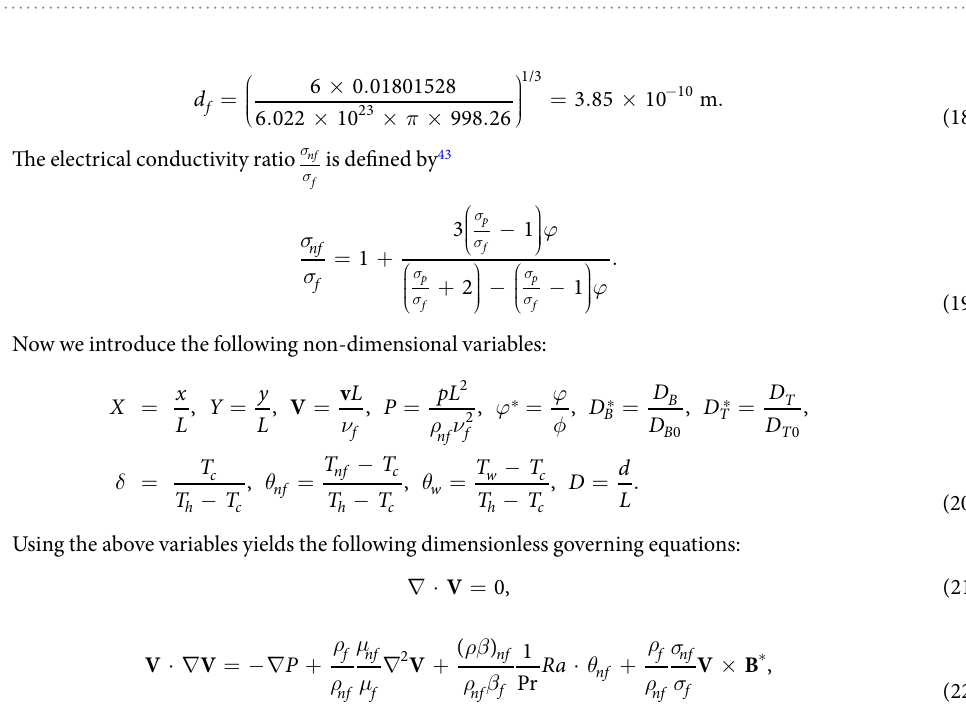
Figure 18. Variation of average Nusselt number with ( a ) φ and ( b ) D for different k w at Ra = 10 5 , Ha = 15 and D =